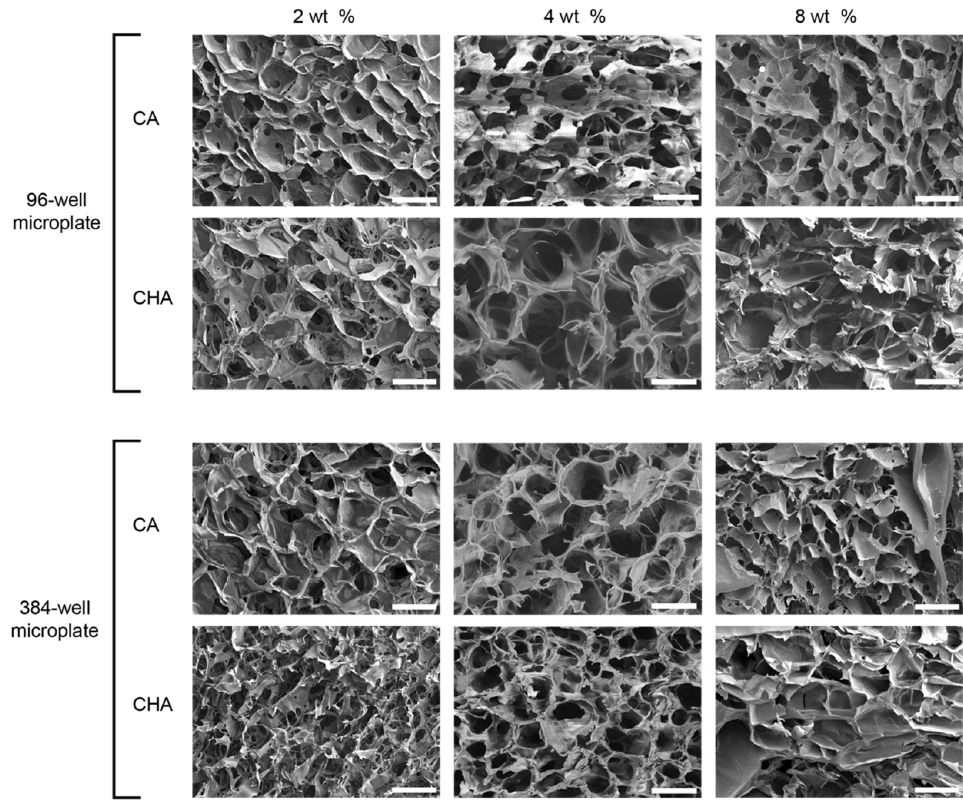
Figure 6. Evaluation of scaffold microstructure in both 96- and 384-well plates. Cross-sectional SEM images of CA and CHA scaffolds of 2, 4, and 8 wt % polymer cast in 96- and 384-well plates. Scale bars represent 100 µ m.